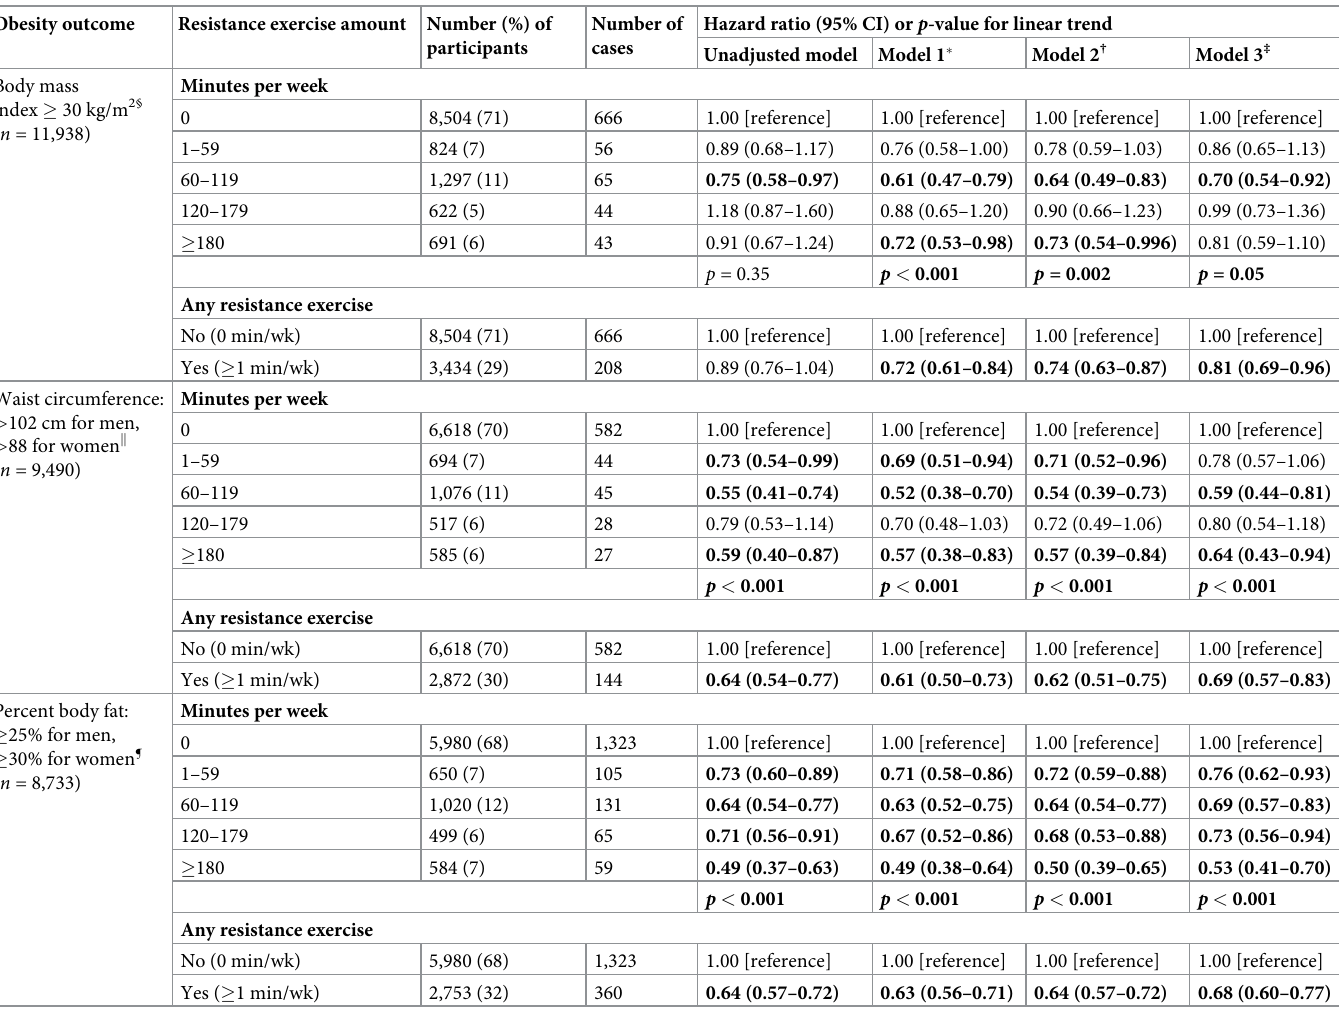
Table 2. Hazard ratios for incident obesity as defined by body mass index, waist circumference, or percent body fat by weekly minutes of resistance exercise. Obesity